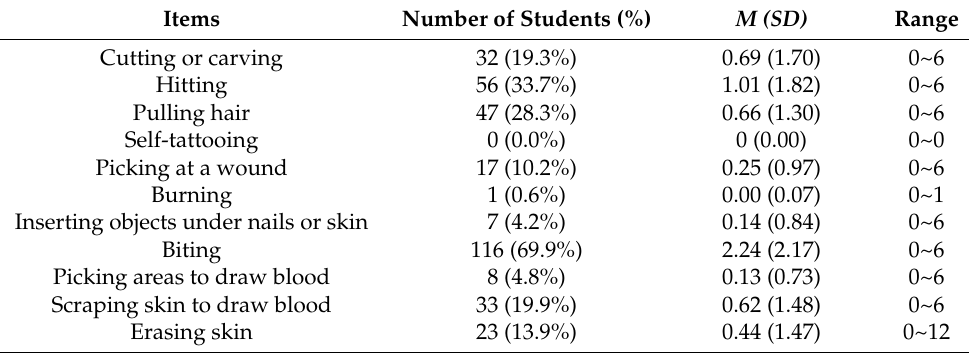
Table 2. Methods and frequency of self-injurious behaviors during